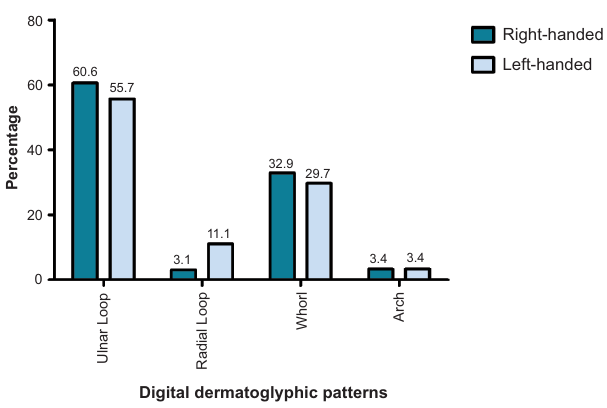
Figure 4. Digital dermatoglyphics pattern distributions in both hands of